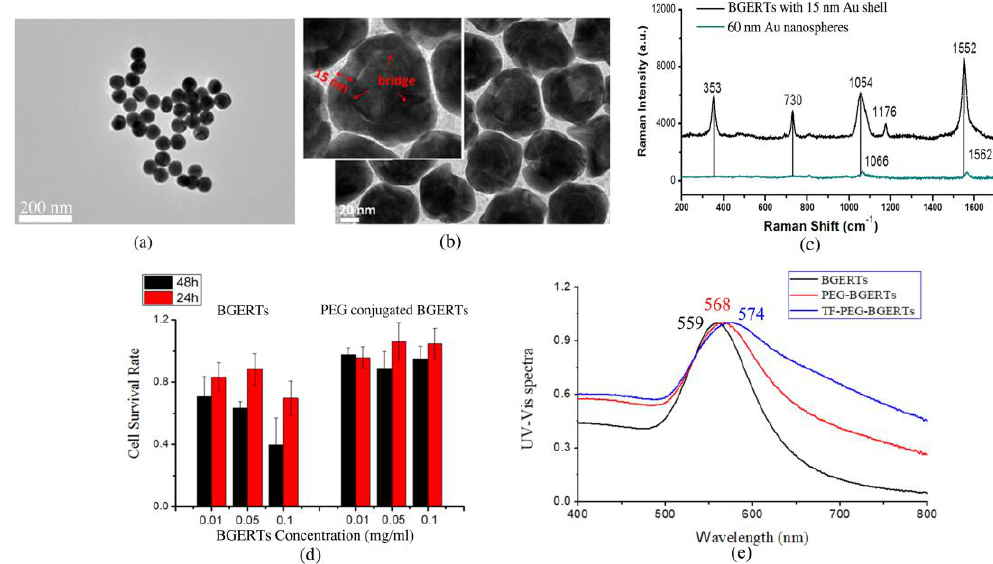
Figure 2. Transmission electron microscopy (TEM) images of ( a ) 60 nm Au (gold) nanospheres, ( b ) BGERTs with 15 nm Au shell, ( c ) Raman spectra of ( a ) and ( b ), ( d ) the survival rate of HeLa cells, in which HeLa cells were respectively cultured with the bare BGERTs and PEG-BGERTs with different concentrations, ( e ) the UV-Vis spectra of BGERTs, PEG-BGERTs and TF-PEG-BGERTs, respectively.